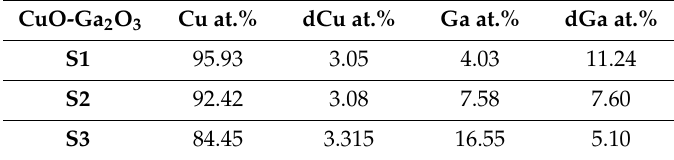
Table 3. Atomic concentration of copper and gallium from X-ray spectroscopy